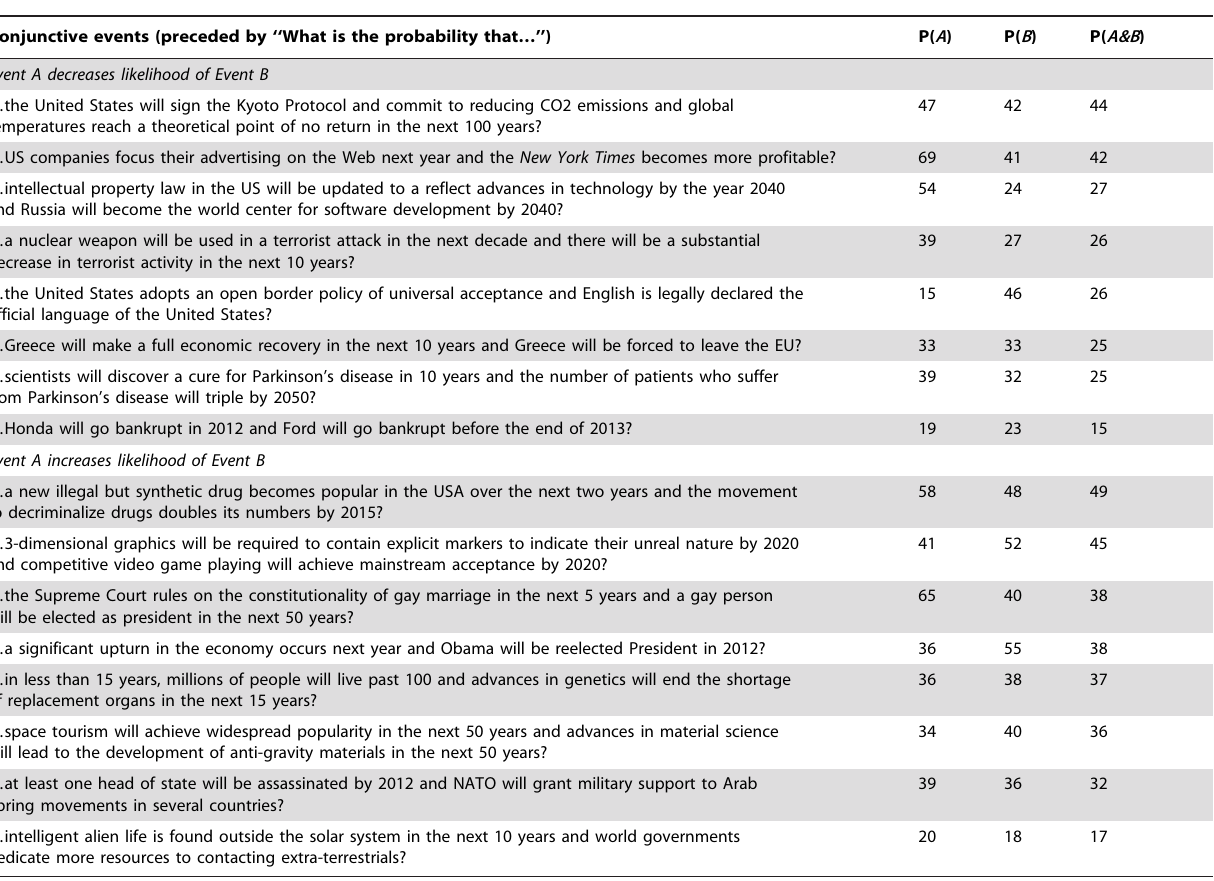
Table 2. The conjunctive events of the 16 contents for the problems in Experiment 1, and their respective mean percentage probability